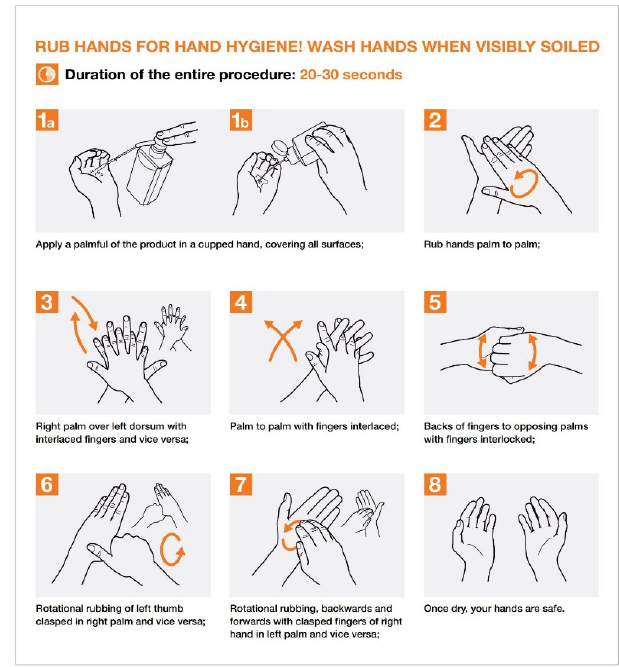
Figure 5. How to Hand Rub? [From: WHO Patient safety. Hand Hygiene: Why, How & When? Revised August 2009 https: // www.who.int / gpsc / 5may / tools / workplace_reminders / en / (Accessed on 24 March